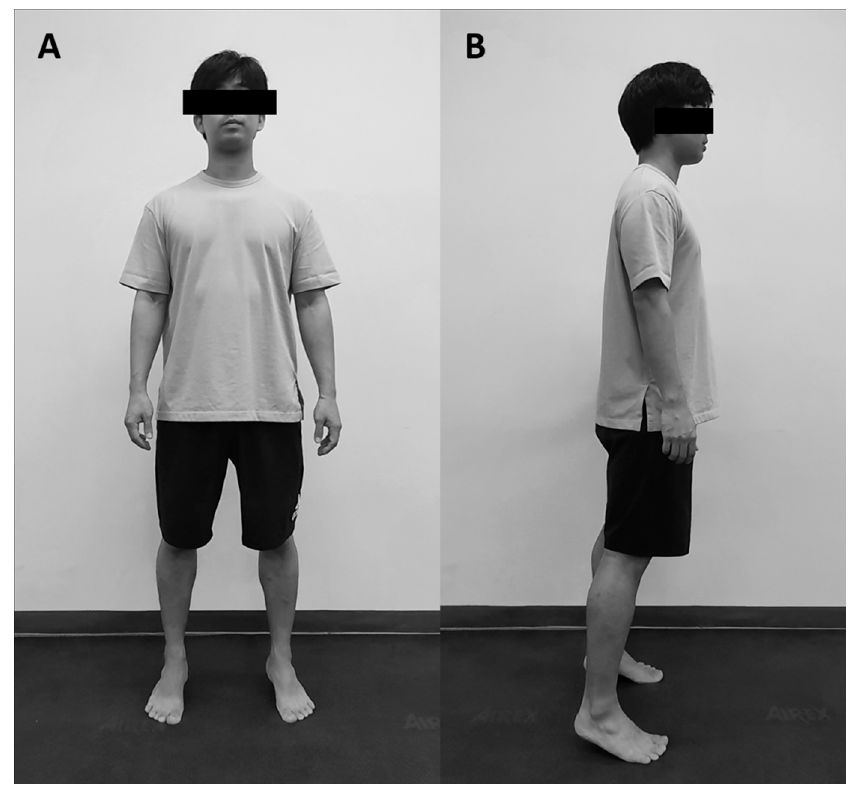
Figure 3. Tiptoe exercise. ( A ) Front view; ( B ) Lateral view.